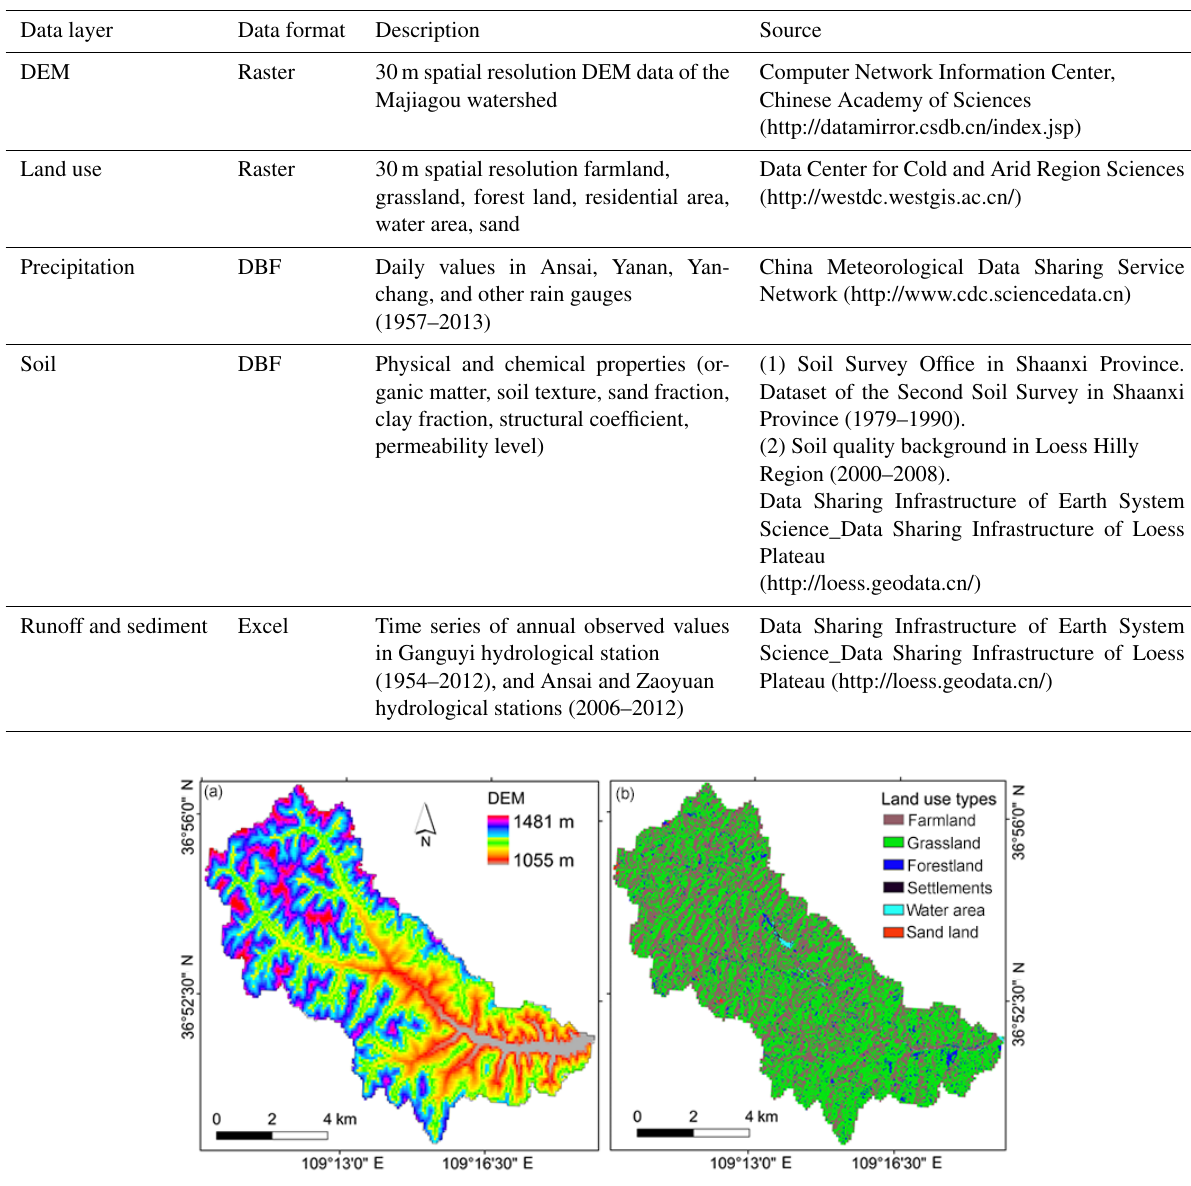
Table 1. Description and source of the environmental database in the Majiagou River watershed.